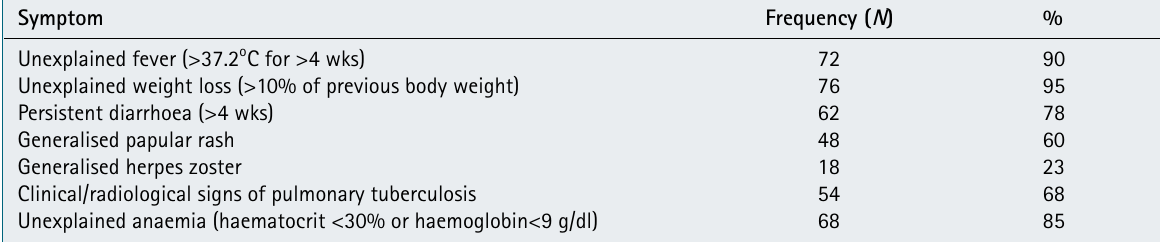
taBle ii. clinical cHaracteriSticS oF tHe SYMPtoMatic HiV-PoSitiVe